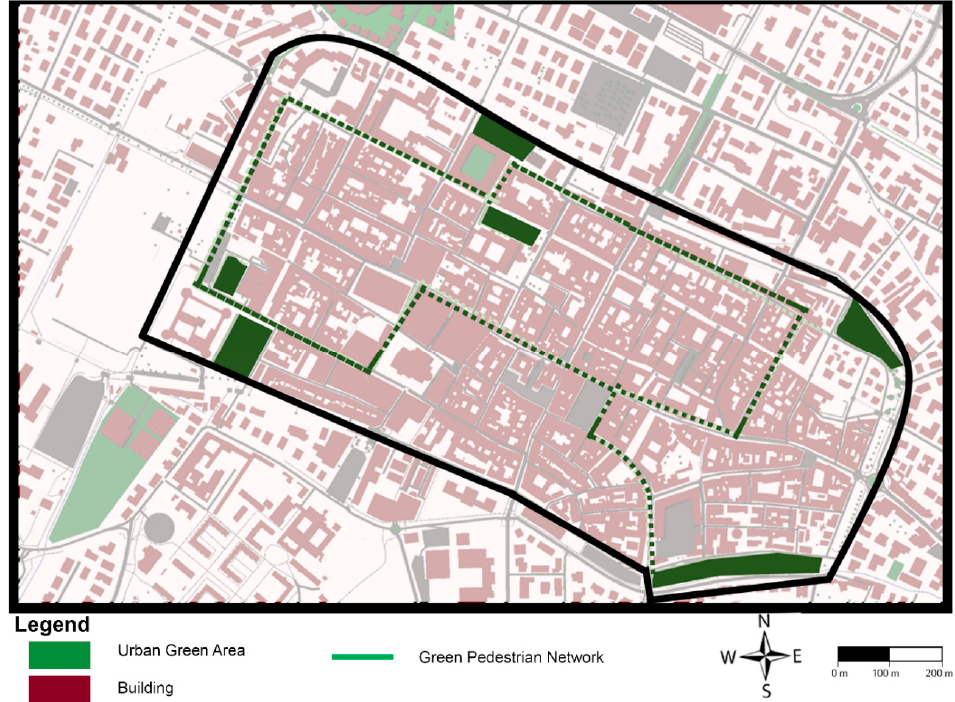
Figure 8. The Network of Green Pedestrian routes in the historical center of Imola.